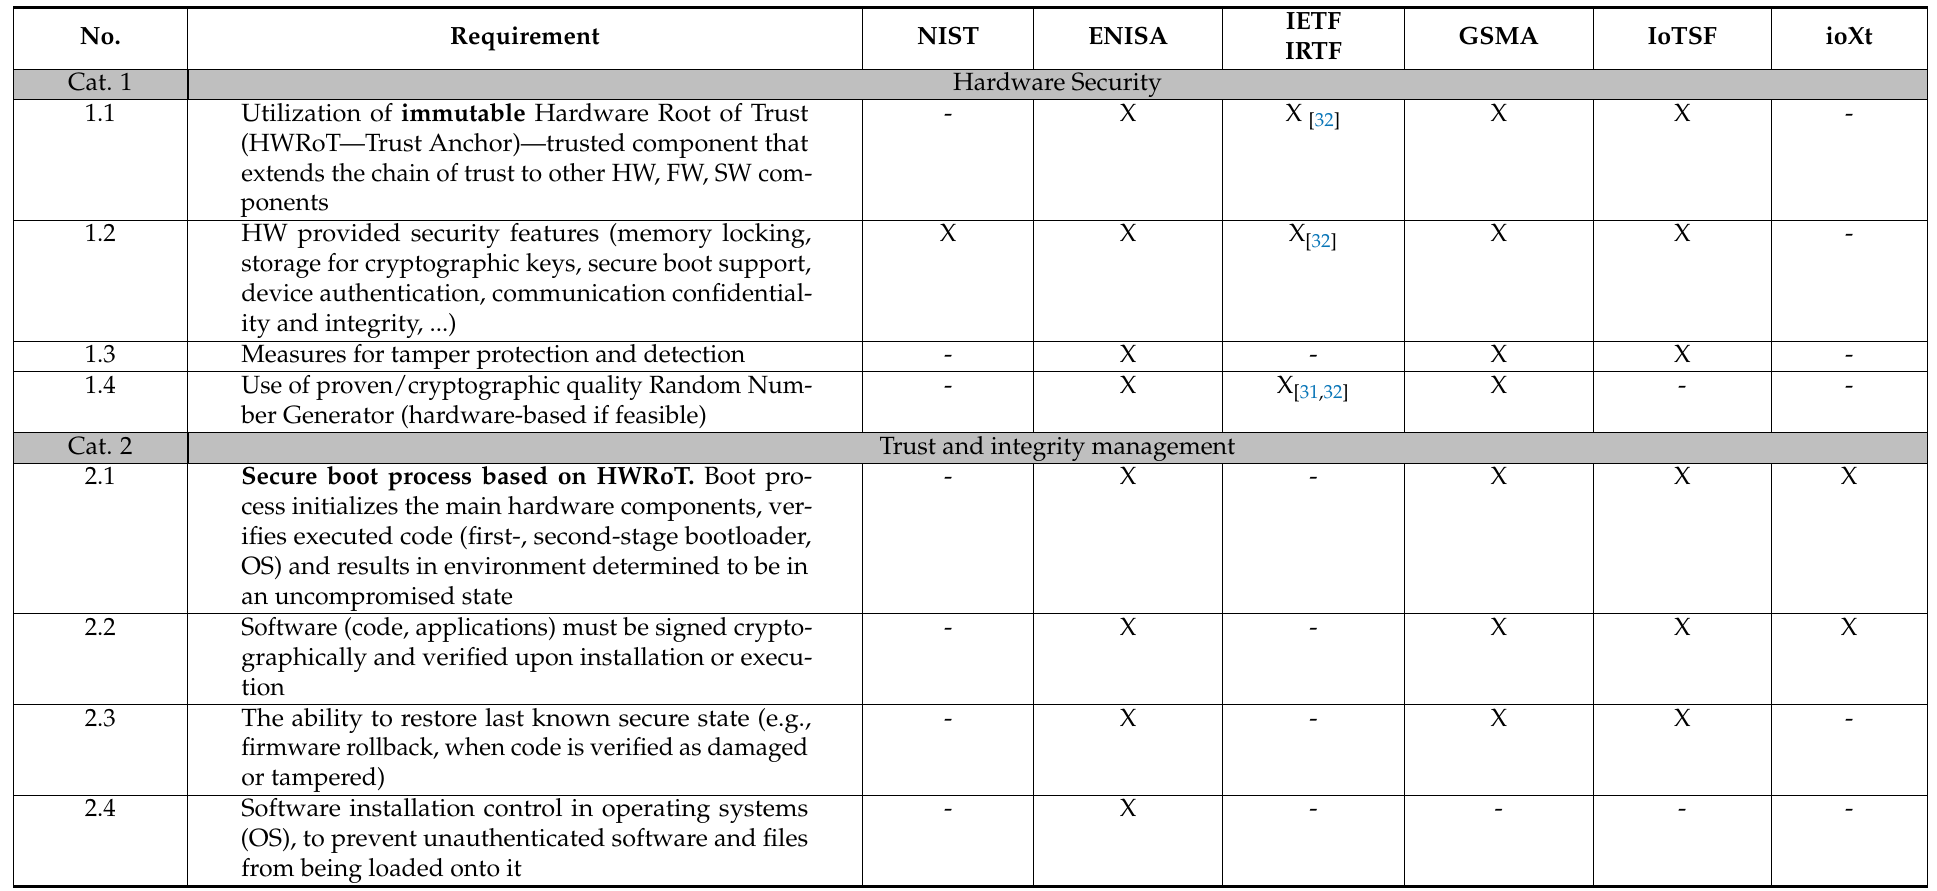
Table 1. Synthesized requirements for secure IoT